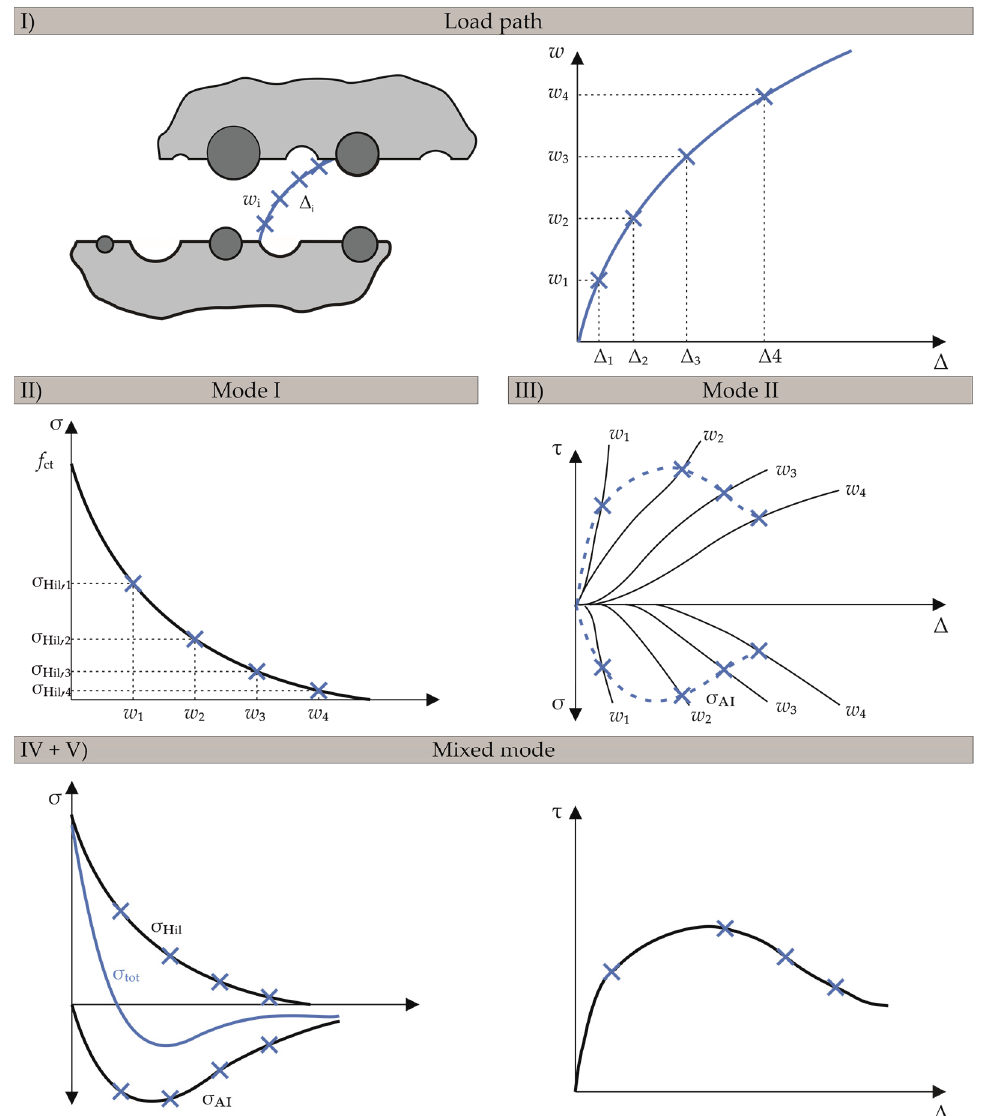
Figure 4. Key concept of the fictitious rough crack model (FRCM), (I) definition of load path, (II) determination of tensile stresses according to Hillerborg [2], (III) pure shear mode analysis, (IV) and (V) computation of the resulting stresses.